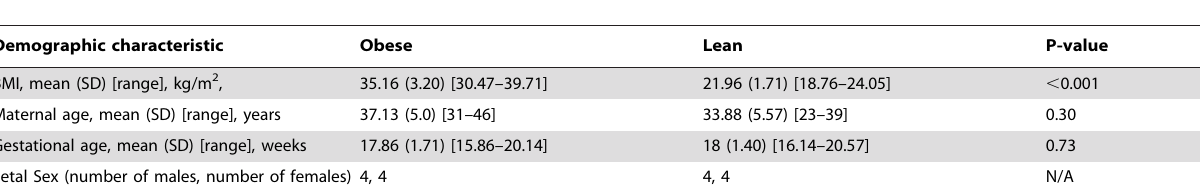
Table 1. Demographic characteristics of obese and lean subjects.